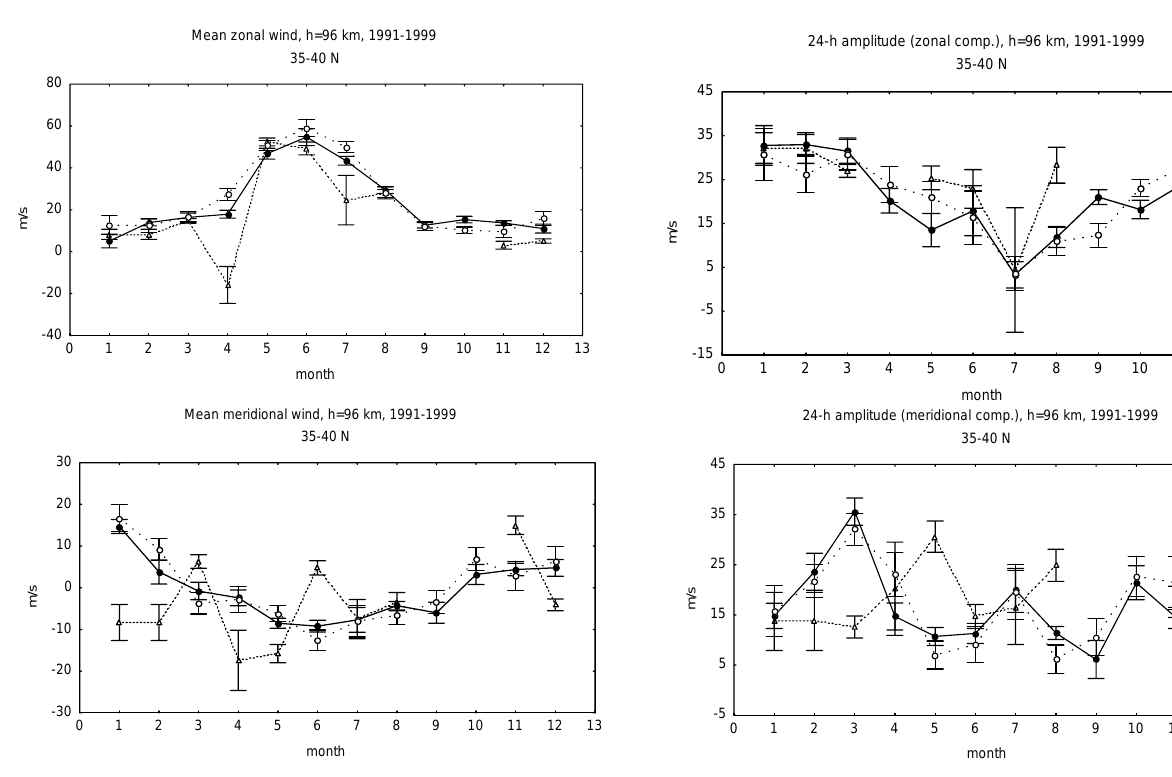
Fig. 3. Same as Fig. 2, except for amplitude of diurnal